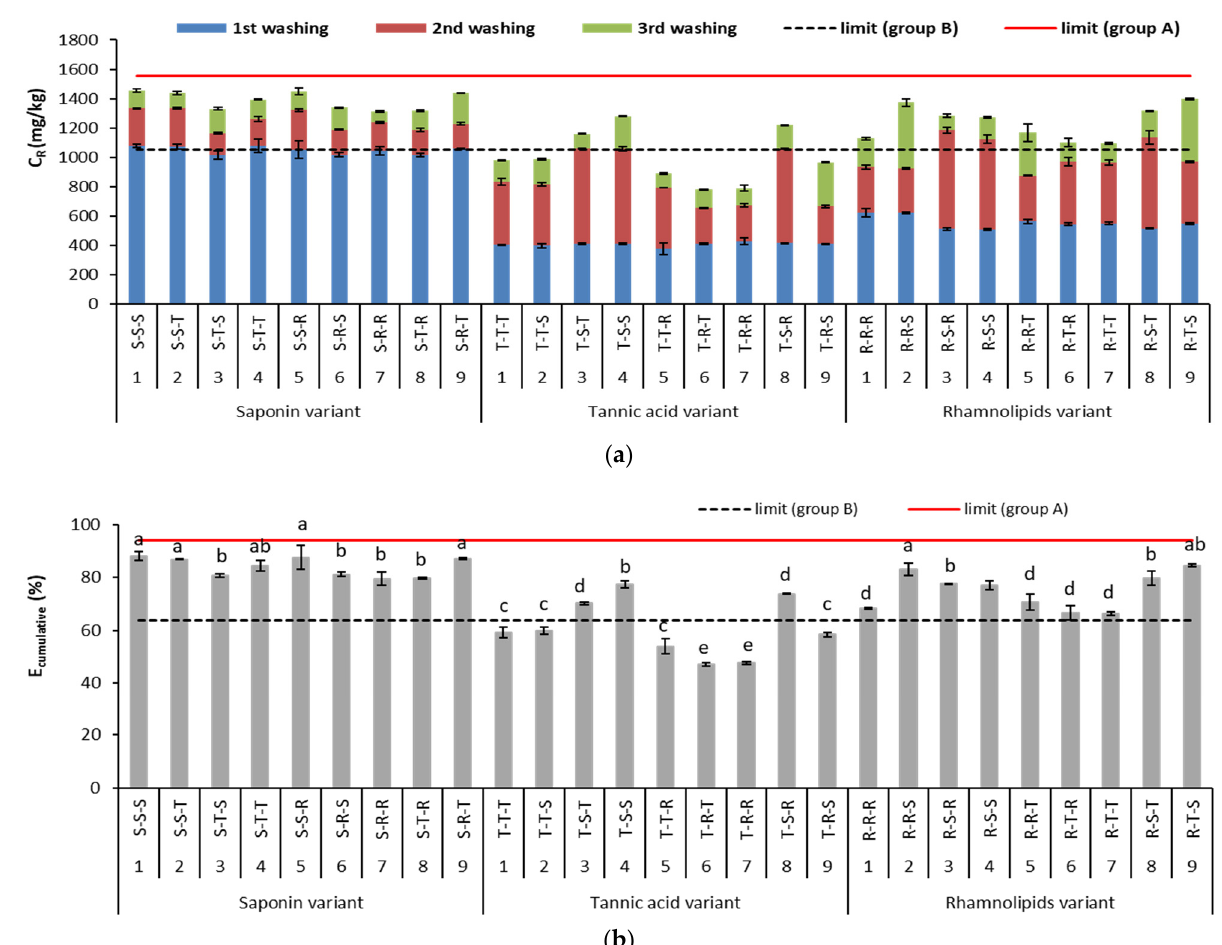
Figure 3. Concentration of metal removed (C R ) ( a ) and cumulative efficiency of Cu removal (E cumulative ) ( b ) during sequential soil washing. For E cumulative , different letters indicate significant differences in metal removal efficiency with different biosurfactant sequences ( p < 0.05). Limit (group A) and limit (group B) mean minimum Cu concentration to be removed from soil or minimum Cu removal efficiency to meet limit values for agricultural and industrial areas, respectively.